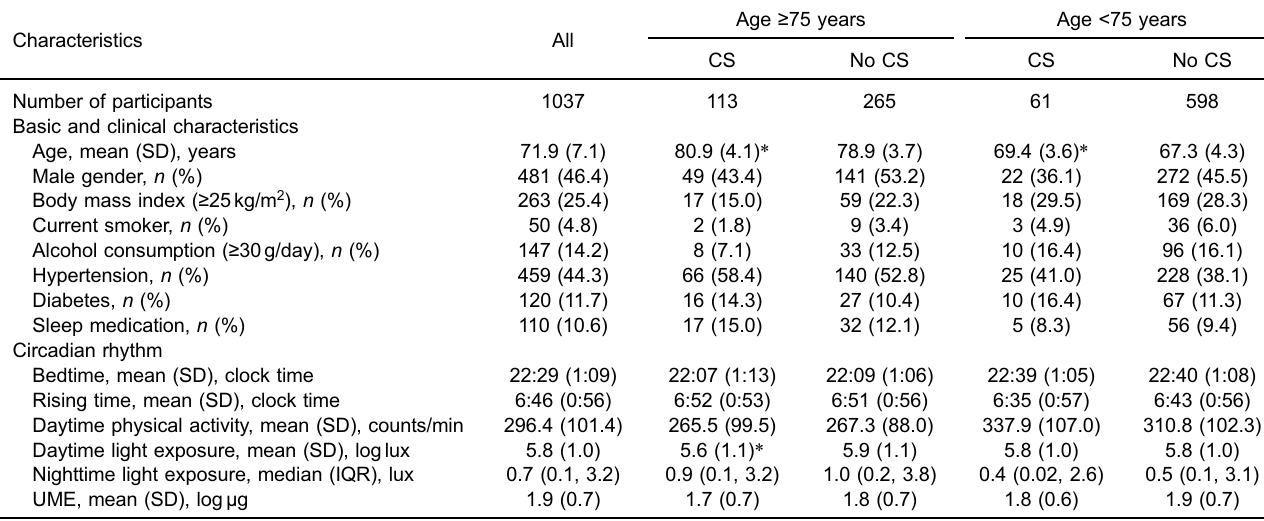
Table 1. Basic, clinical, and circadian rhythm characteristics by CS status